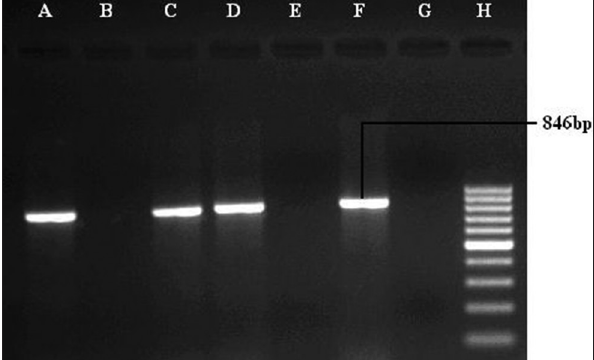
Figure-9: Polymerase chain reaction for the detection of toxA gene (846 bp) of Pasteurella multocida. Lane A, C, D, and F: Samples positive for toxA gene. Lane B, E, and G: Samples negative for toxA gene. Lane H: 100 bp DNA